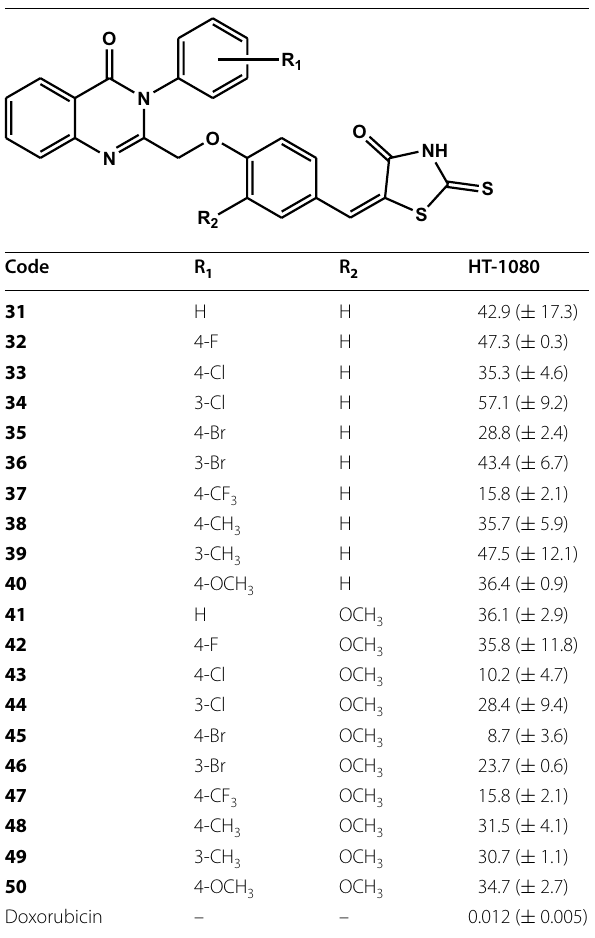
Table 1 Cytotoxicity of test compounds against HT-1080